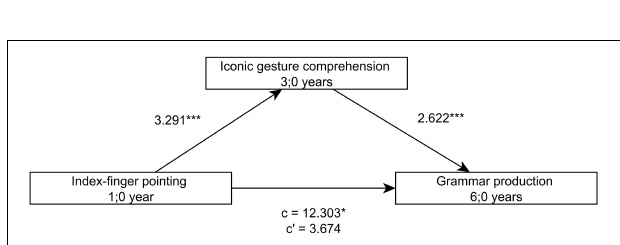
FIGURE 5 | Model of index-finger pointing at 1;0 as a predictor of productive grammar skills at 6;0, mediated by iconic gesture comprehension at 3;0.